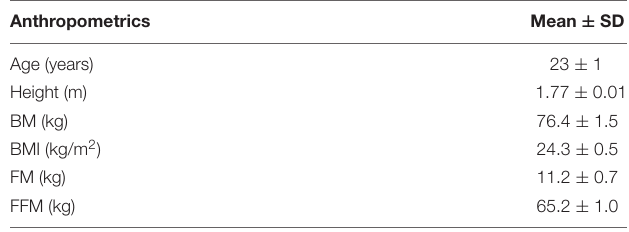
TABLE 1 | Physical characteristics of the participants ( n =